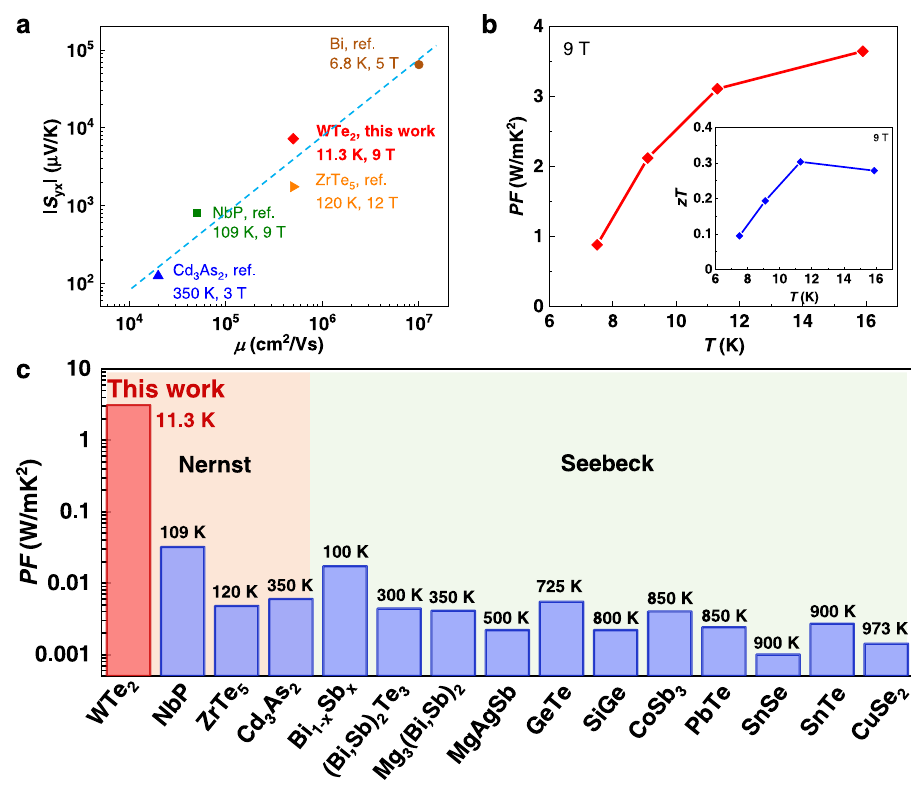
Fig. 4 Comparison of high-performance thermoelectric semiconductors. a Nernst thermopower and mobility of various topological semimetals and Bi. b temperature dependence of Nernst power factor of WTe 2 , inset shows the zT values. c Nernst power factor of various topological semimetals including NbP 8,40 , ZrTe 5 36 and Cd 3 As 2 37 , and a comparison with the Seebeck power factors of high-performance thermoelectric semiconductors including Bi 1-x Sb x 39 , (Bi,Sb) 2 Te 3 38 , Mg 3 (Bi,Sb) 2 41 , MgAgSb 42 , GeTe 43 , SiGe 44 , CoSb 3 45 , PbTe 46 , SnSe 47 , SnTe 48 , and CuSe 2 49